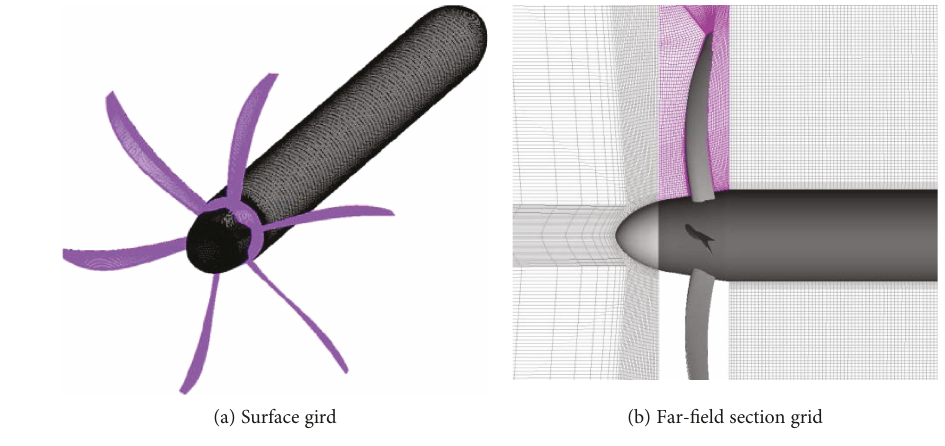
Figure 6: Block-structured grids of an isolated SRP.